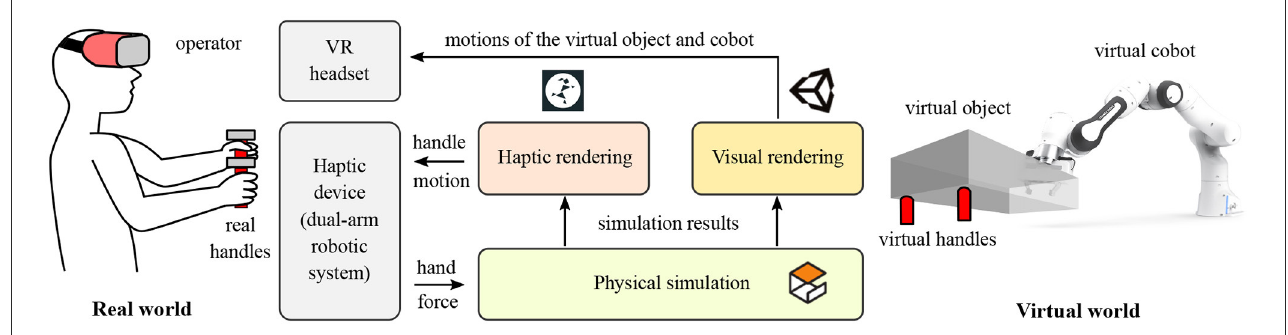
FIGURE2 Schematic diagram of PREDICTOR and its components. The hardware includes a dual-arm robotic system as a haptic device and a VR headset. The software consists of three modules including physical simulation, haptic rendering and visual rendering